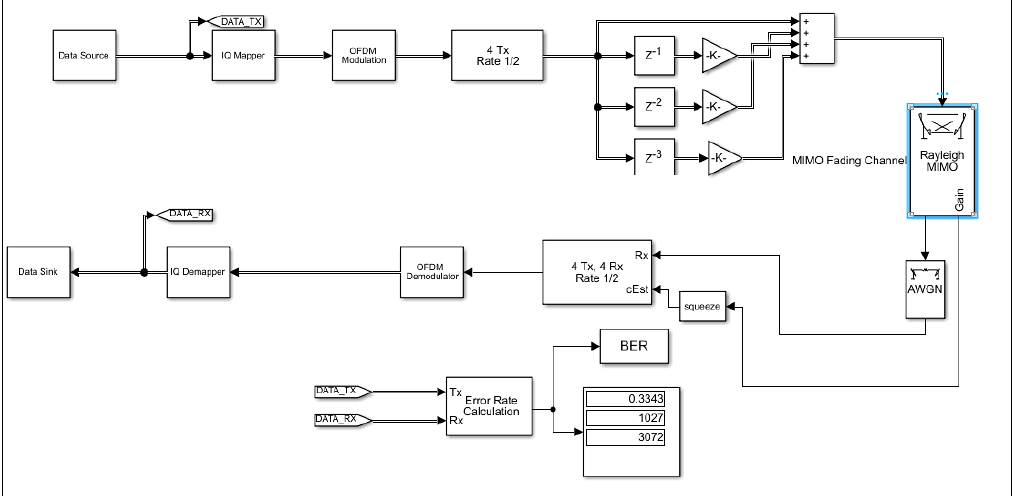
Figure 11. 4×4 LMS-MIMO-OFDM Model in Rayleigh Channel.